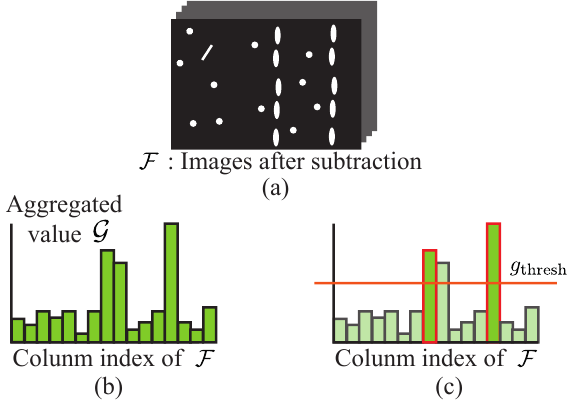
Figure 3. Waterdrop trajectory detection. ( a ) Images obtained after background subtraction. Wa- terdrops and radiation noise are extracted from the images. ( b ) Vertically ggregated values of F . ( c ) Waterdrop trajectory detection followed by non-maximum suppression. The red rectangles represent the final detection